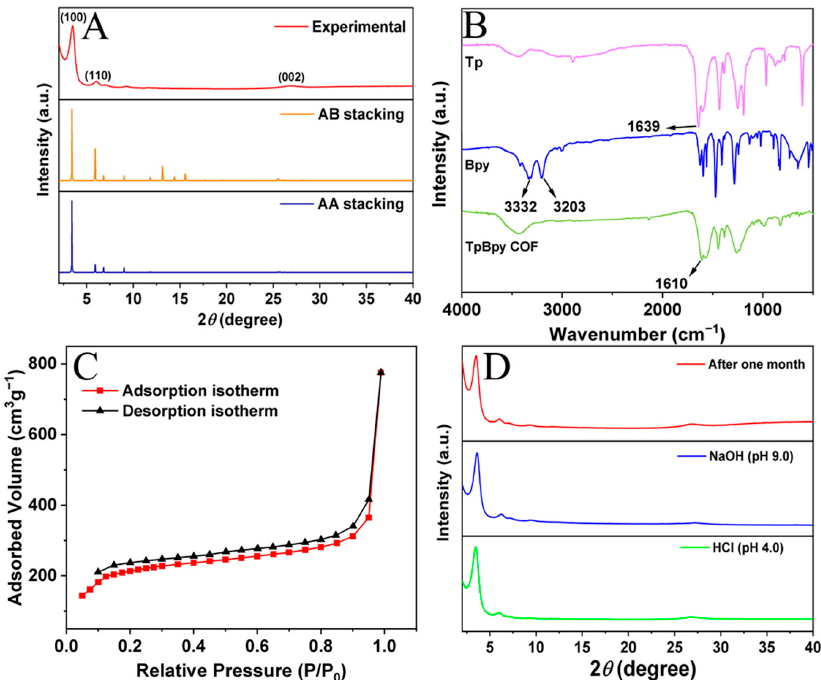
Figure 2. ( A ) Experimental and the simulated XRD pattern of TpBpy COF. ( B ) FT-IR spectra of Tp, Bpy, and TpBpy COF. ( C ) N 2 adsorption and desorption isotherm of TpBpy COF. ( D ) XRD pattern of TpBpy COF after one month of storage and treatment in HCl (pH 4.0) and NaOH (pH